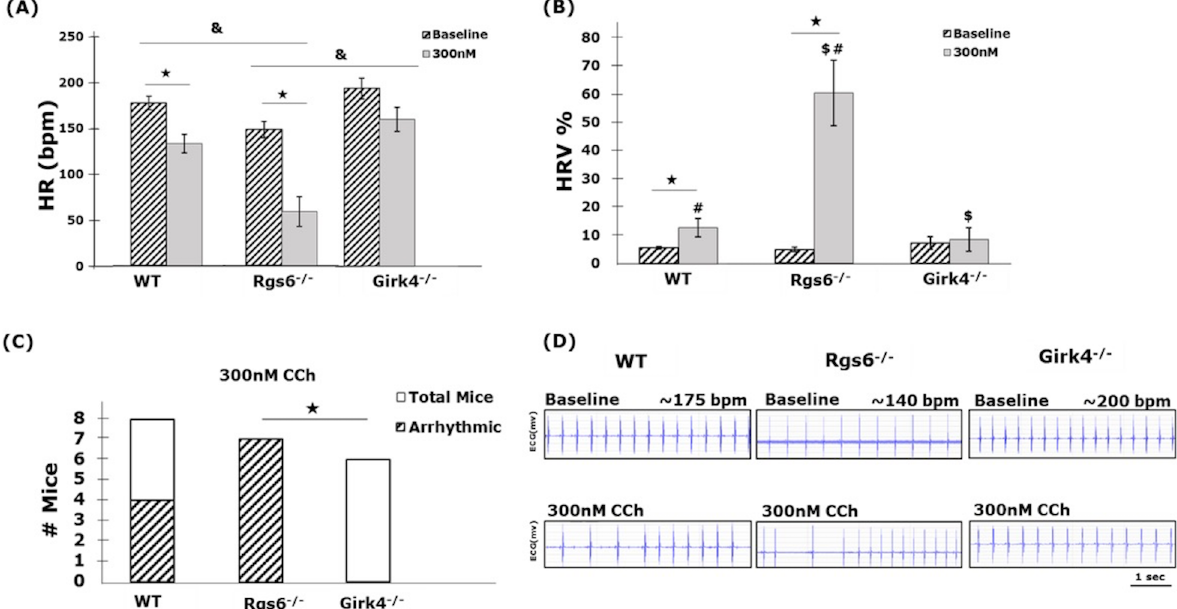
Fig 1. The influence of M 2 R-I KACh signaling on in vivo HR and HRV. Summary of baseline and post-CCh (300nM CCh) in-vivo HR (A) and HRV (B) in WT, Rgs6 -/- , and Girk4 -/- mice. (‘ (cid:3) ’ denotes statistical significance of p < 0.05 between baseline and CCh within the same genotype. ‘&’ denotes a statistically significant (p < 0.05) difference for both baseline and CCh when comparing between two genotypes). ‘#’ denotes statistical significance of p < 0.05 between WT and Rgs6 -/- mice post-CCh. ‘$’ denotes statistical significance of p < 0.05 between Girk4 -/- and Rgs6 -/- mice post-CCh. Statistics performed using 1-way ANOVA.) (C) Quantification of the total number of mice that exhibited arrhythmias post CCh. (‘ (cid:3) ’ denotes statistical significance of p < 0.05 between Girk4 -/- and Rgs6 -/- . Statistics performed using Fisher’s exact test). (D) Representative examples of ECG data during control and demonstrating episodes of arrhythmia in WT and Rgs6 -/- , and no arrhythmia in Girk4 -/- mice post CCh. n = 8, 8, 6 for WT, Rgs6 -/ - , and Girk4 -/- ,